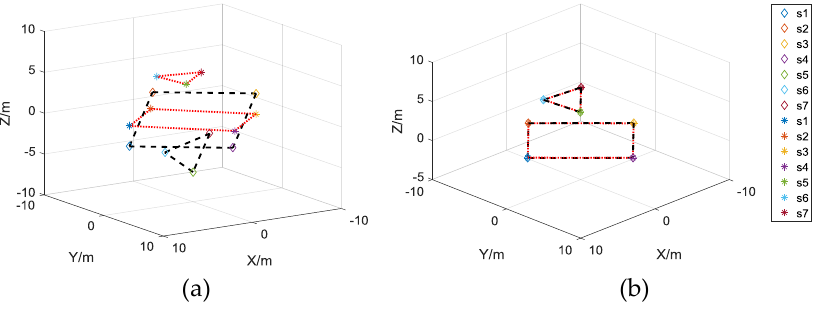
Figure 7. The effect of the unitary ambiguity 3D rotation matrix on the 50th sub-image. (a) The noise Figure 7. The e ff ect of the unitary ambiguity 3D rotation matrix on the 50th sub-image. ( a ) The noise is 0.5 times of the range resolution. ( b ) The noise is 5 times of the range resolution. Remote Sens. 2019 , 11 , x FOR PEER REVIEW is 0.5 times of the range resolution. (b) The noise is 5 times of the range resolution.